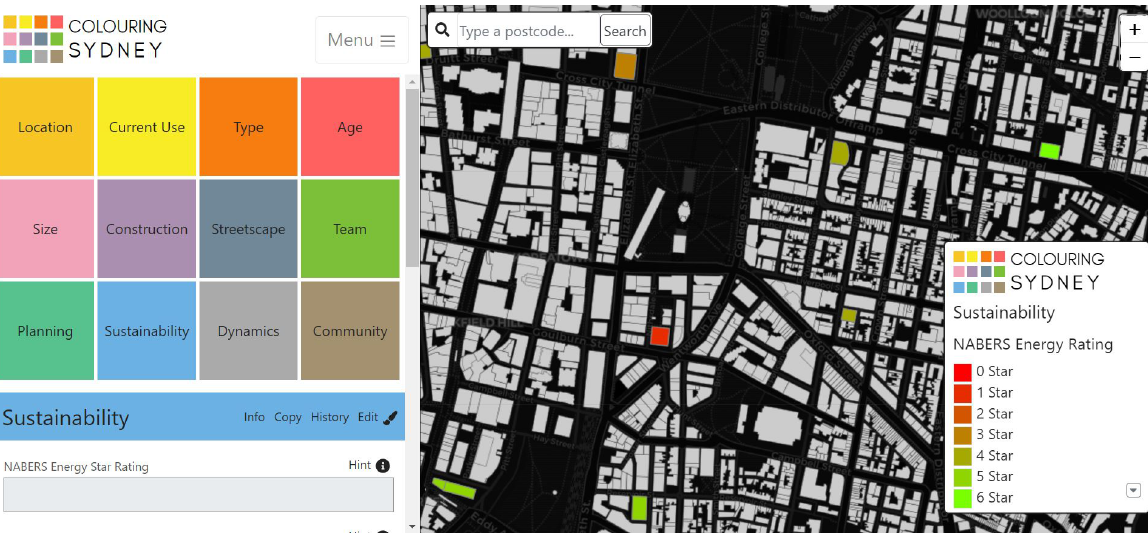
Figure 1. NABERS: building footprints in inner Sydney with Energy Rating